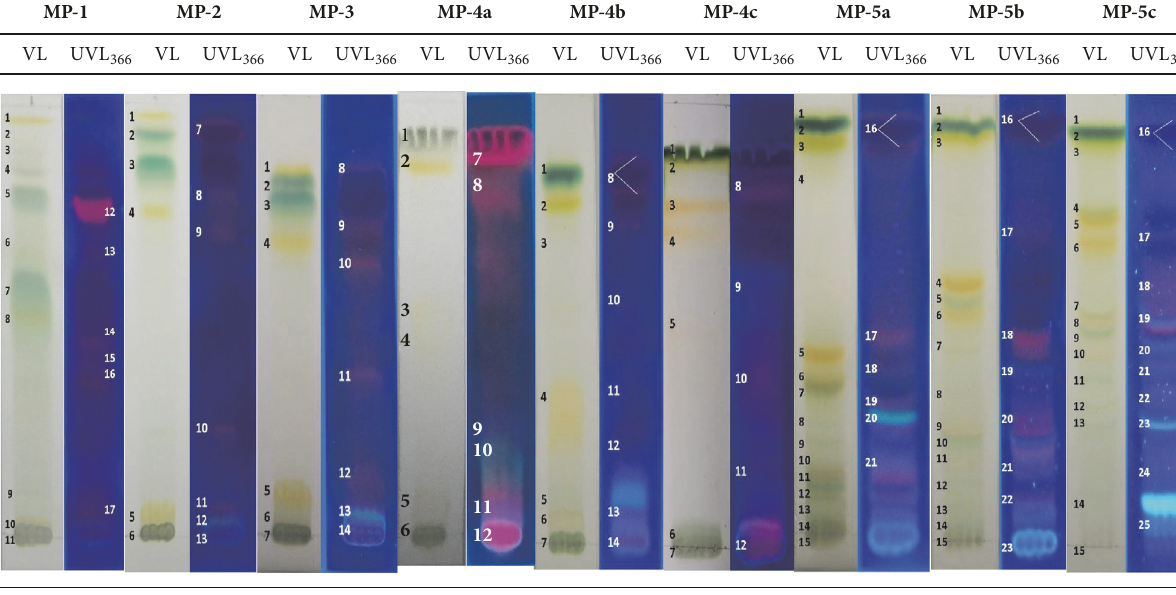
modifier (MP4a: T= 12 and W=5; MP-4b: T=14 and